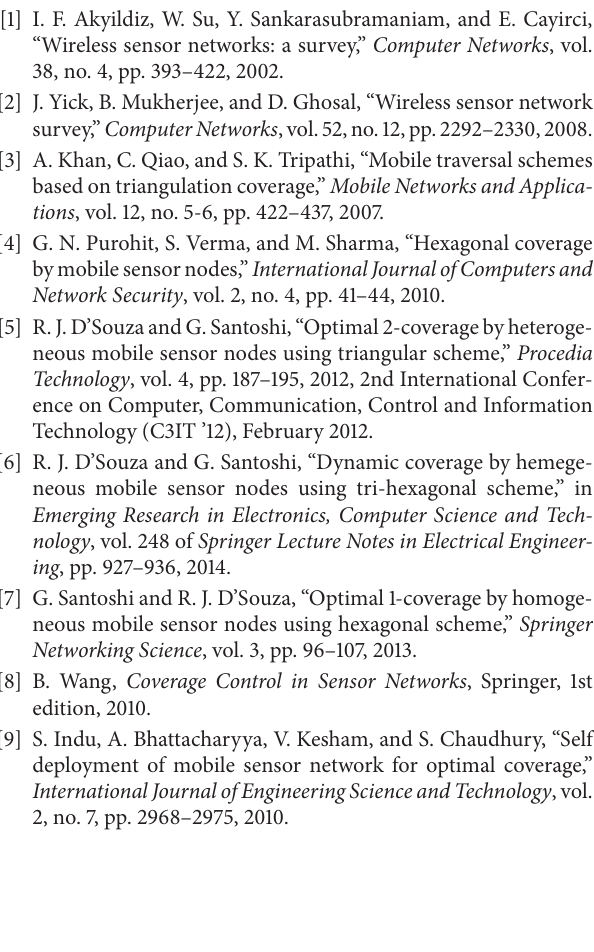
Algorithm 1. In Algorithm 2 we denote 𝑋 UB and 𝑌 UB as upper bounds of coordinates of the corresponding traversal. Every traversal pattern has its own upper and lower bounds for the coordinates as shown in Section